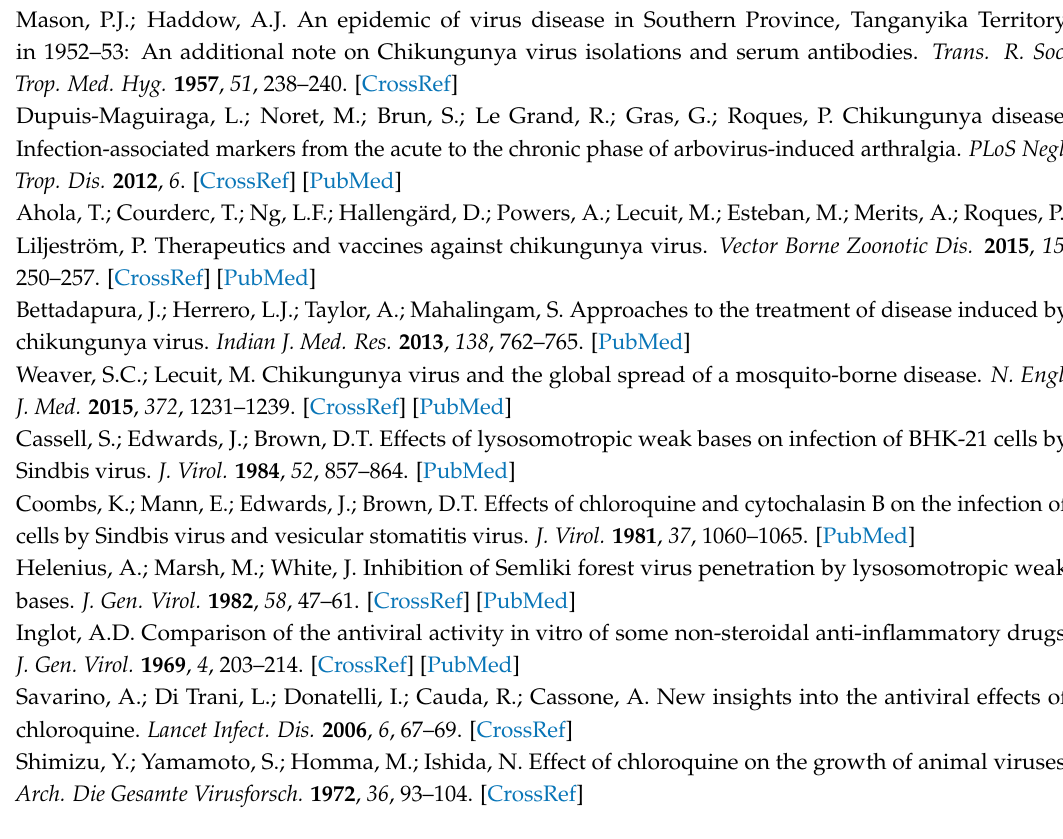
Figure S1: (A) Macaque primary fibroblast cell isolation procedure; (B) Differential impact of chloroquine or CHIKV on primary macaque fibroblast cells (passage 3 to 6). Table S1: Demographic characteristic, clinical and biological presentation at inclusion, Table S2: Univariate analysis of cytokine value in human